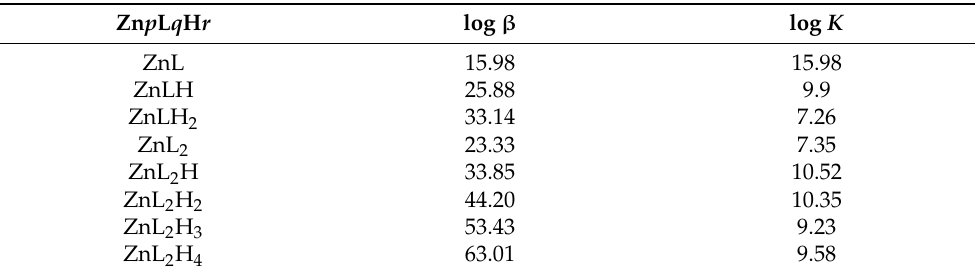
Table 8. Stability constants (log β ) for zinc(II)-peptide complexes of the ZnT8 11-residue C-terminal peptide, ionic strength 0.1 M (KNO 3 ), 25 ◦